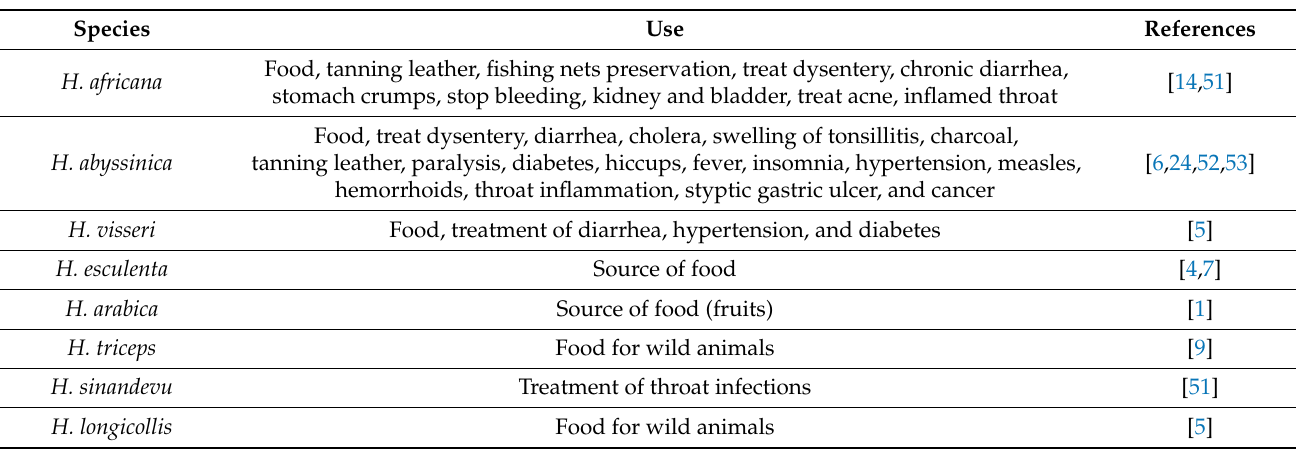
Table 2. The uses of Hydnora species.